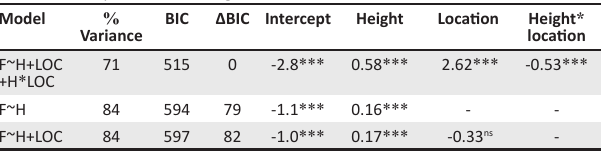
TABLE 1: Comparison three logistic